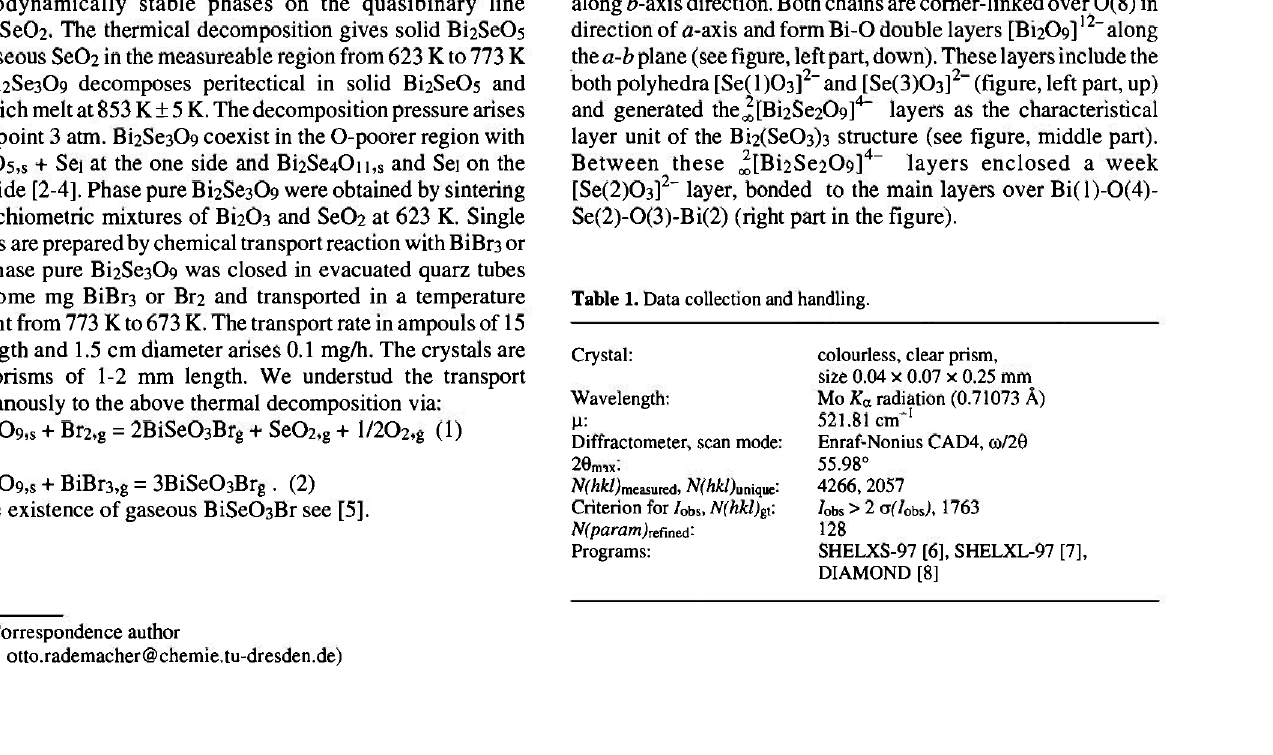
Table 1. Data collection and handling.